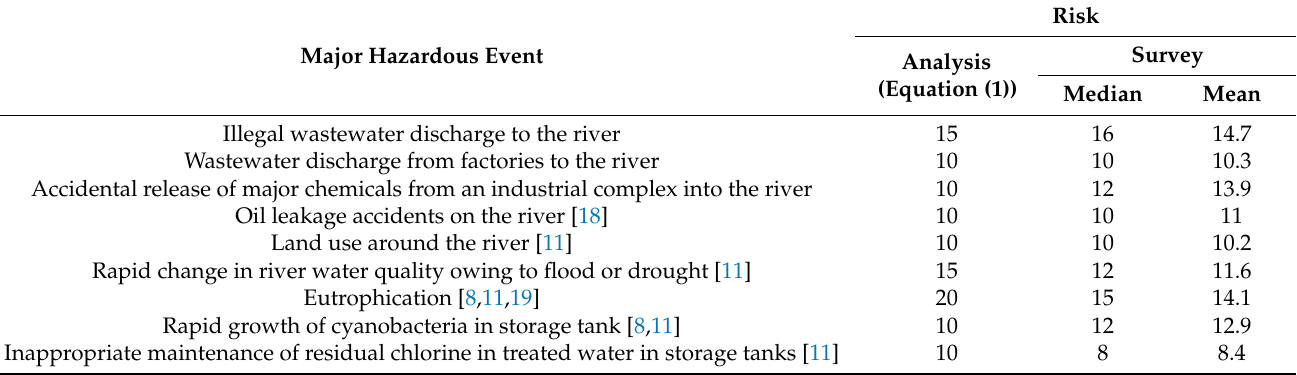
Table 4. Results of the survey of professionals on the risk of major hazardous